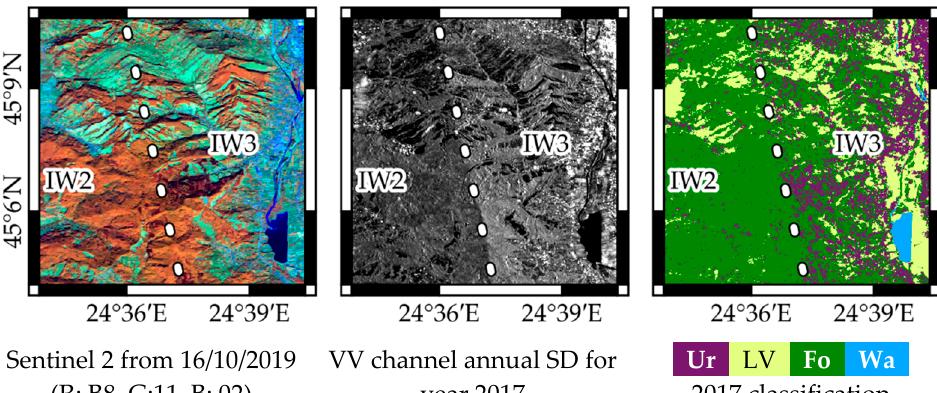
Figure 7. Annual (2017) SD for VV polarization for orbit 29 (subset), and the derived classification for said orbit prior to classification merging. The dotted line represents the limit between both sub-swathes. From left to right: Sentinel-2 image shown as reference, annual SD (VV) and, classified land cover (Ur, urban; LV, low vegetation; Fo, forest; Wa, water). To understand the sub-swathes differences, we plotted the distribution of all pixels labeled as forest in the validation sample disaggregating by orbit, year, and sub-swath (Figure 8). VV and VH annual averages showed little difference between years and sub- swathes, with a near-complete match between the distributions of all years and sub- swathes. However, for year 2017 the VV annual SD for ascending orbits (29, 131) had its distribution shifted compared to years 2018 and 2019. For orbit 29, the distributions for the sub-swathes were centered around different values, whereas both had a similarly high